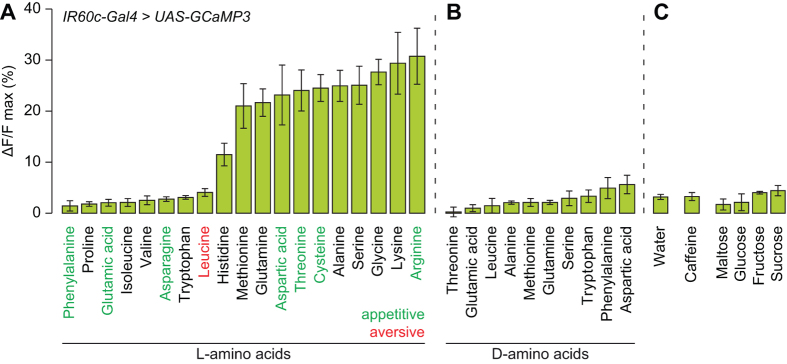
IR60c-Gal4 neurons are sensitive to a subset of amino acids.(A) Peak ΔF/F value observed in neurons of UAS-GCaMP3;IR60c-Gal4 animals after stimulation with 19 individual L-amino acids (200 mM). (Mean response ± SEM is shown; N ≥ 5 animals per stimulus). (B) As in (A) after stimulation with 10 individual D-amino acids (200 mM). (Mean response ± SEM is shown; N ≥ 4 animals per stimulus). (C) As in (A) after stimulation with water, caffeine (50 mM) or sugars (200 mM for maltose, glucose and sucrose; 1 M for fructose). (Mean response ± SEM is shown; N ≥ 3 animals per stimulus).